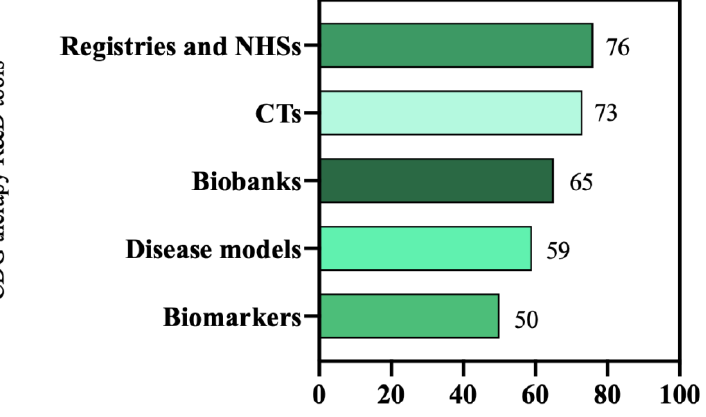
Figure 2. CDG therapeutic R&D tools